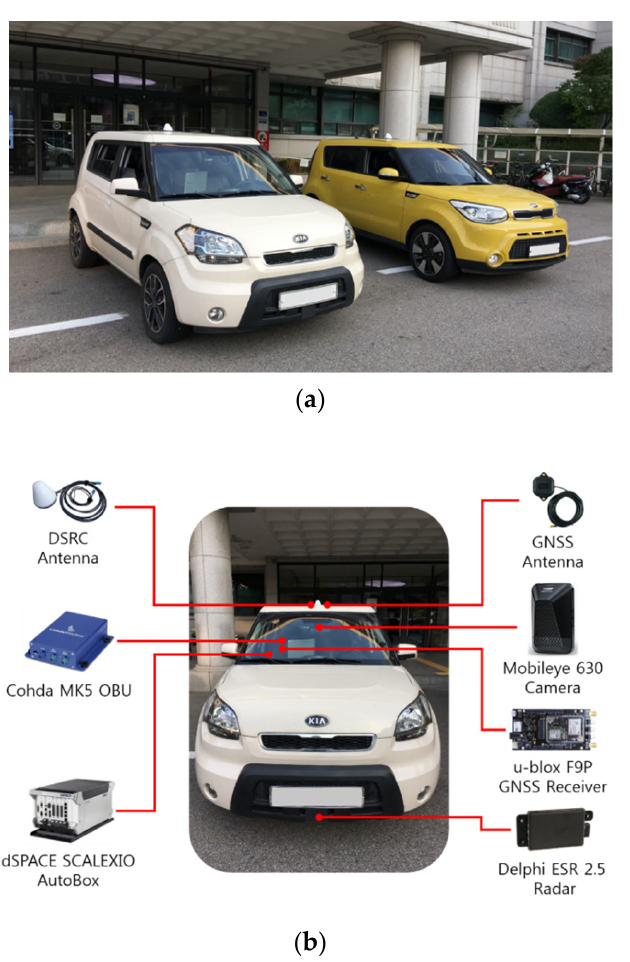
Figure 6. Test vehicles used for the driving experiments. ( a ) The host vehicle (white) and the remote vehicle (yellow); ( b ) experimental equipment installed on the test vehicle.